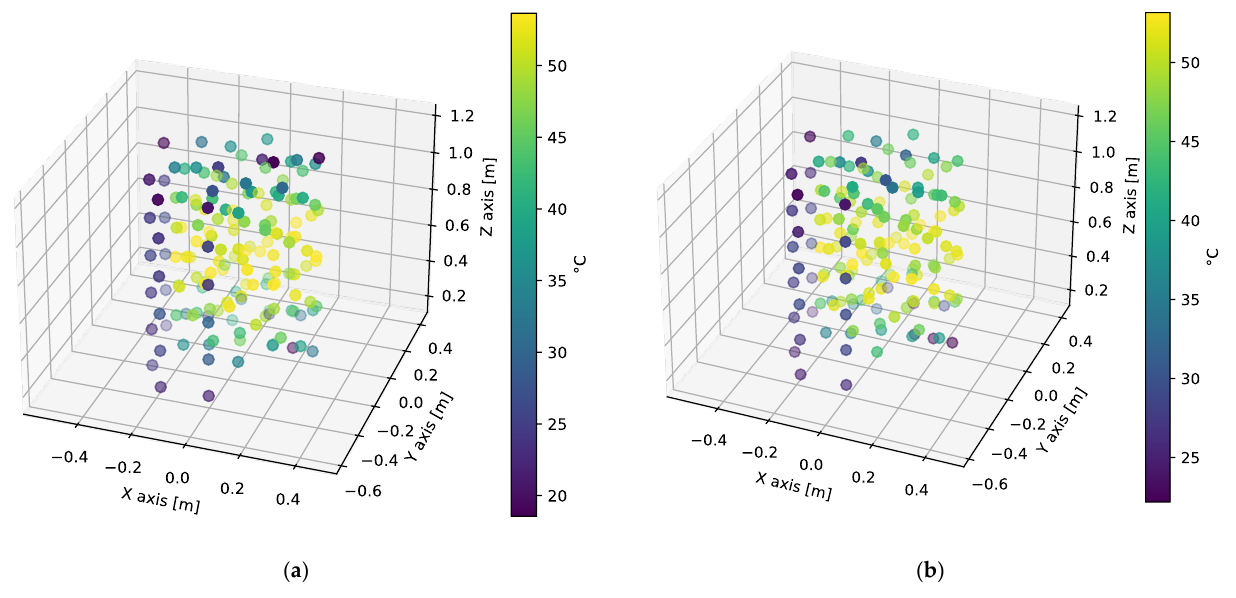
Figure 13. 3D scatter plots of all temperature data points DTS + PT1000; sand ( a ) and soil ( b ).